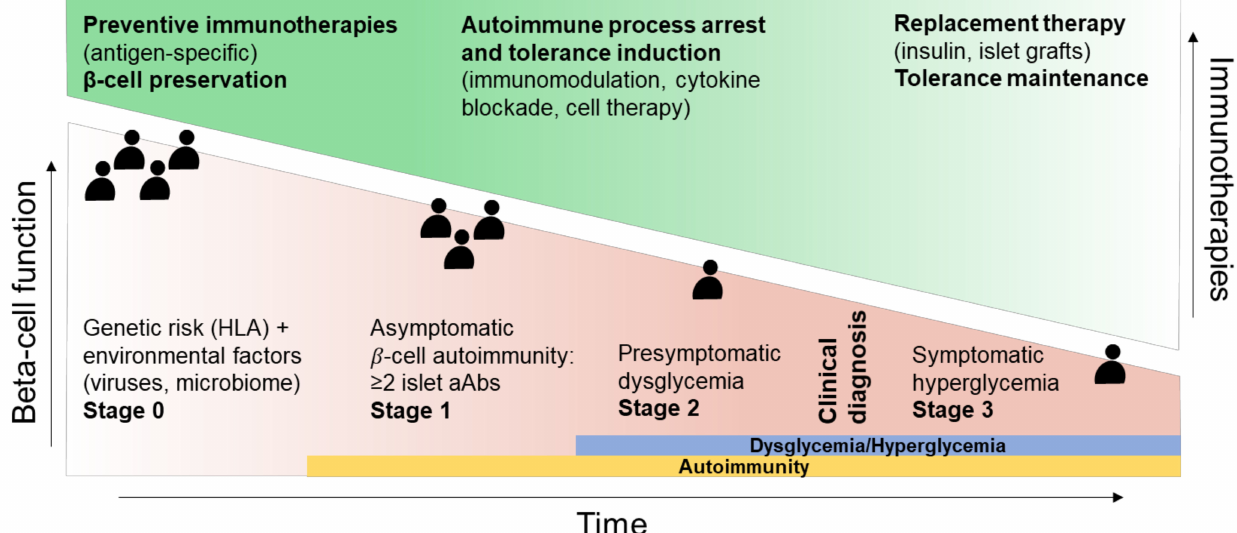
Figure 1. Stage-specific therapeutic intervention in T1D (type 1 diabetes). Stage 0 individuals, without aAbs (autoantibodies) but at risk for developing T1D owing to genetic and/or environmental triggers, are candidates for immunotherapies aiming at preventing T1D and preserving intact β -cell mass, such as antigen-specific and tolerance induction therapies. In subjects with stage 1 and stage 2 disease, characterized by the presence of one or more aAbs and a progressive dysglycemia, therapies